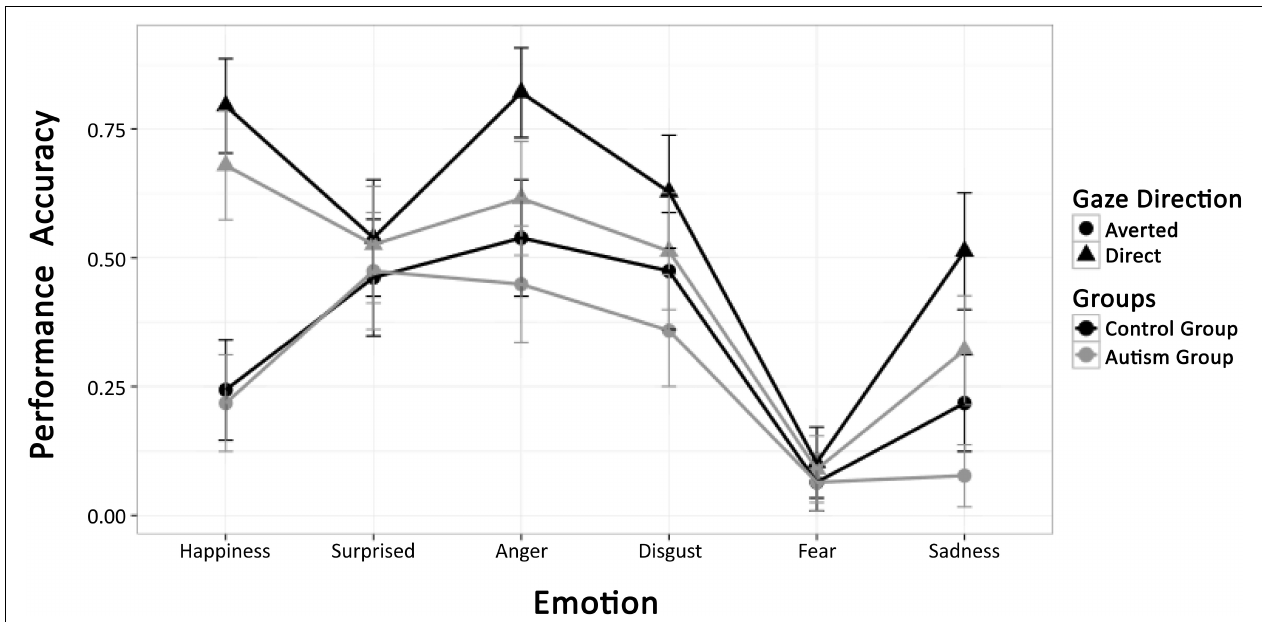
FIGURE 6 | Mean performance accuracy of the ASD and TD groups for all emotion conditions and direct and averted gaze of stimulus faces.